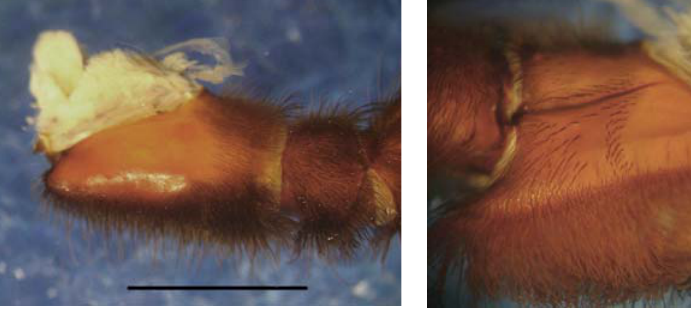
Image 8. Maxillae, retrolateral face. Scale 5.0mm